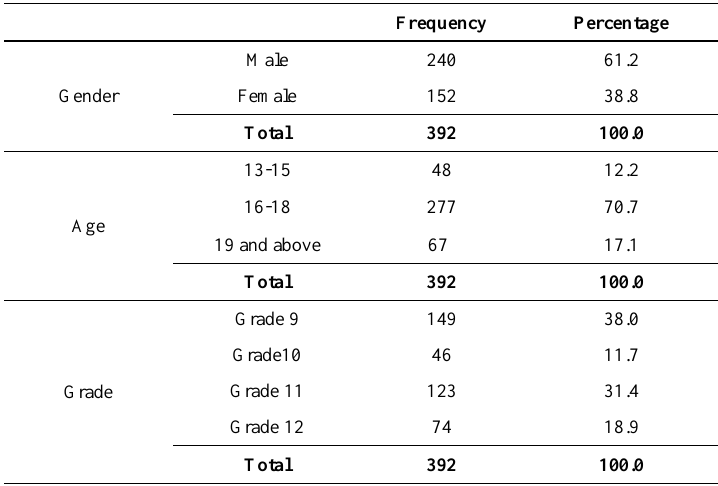
Table 1. Students as study participants (number of schools